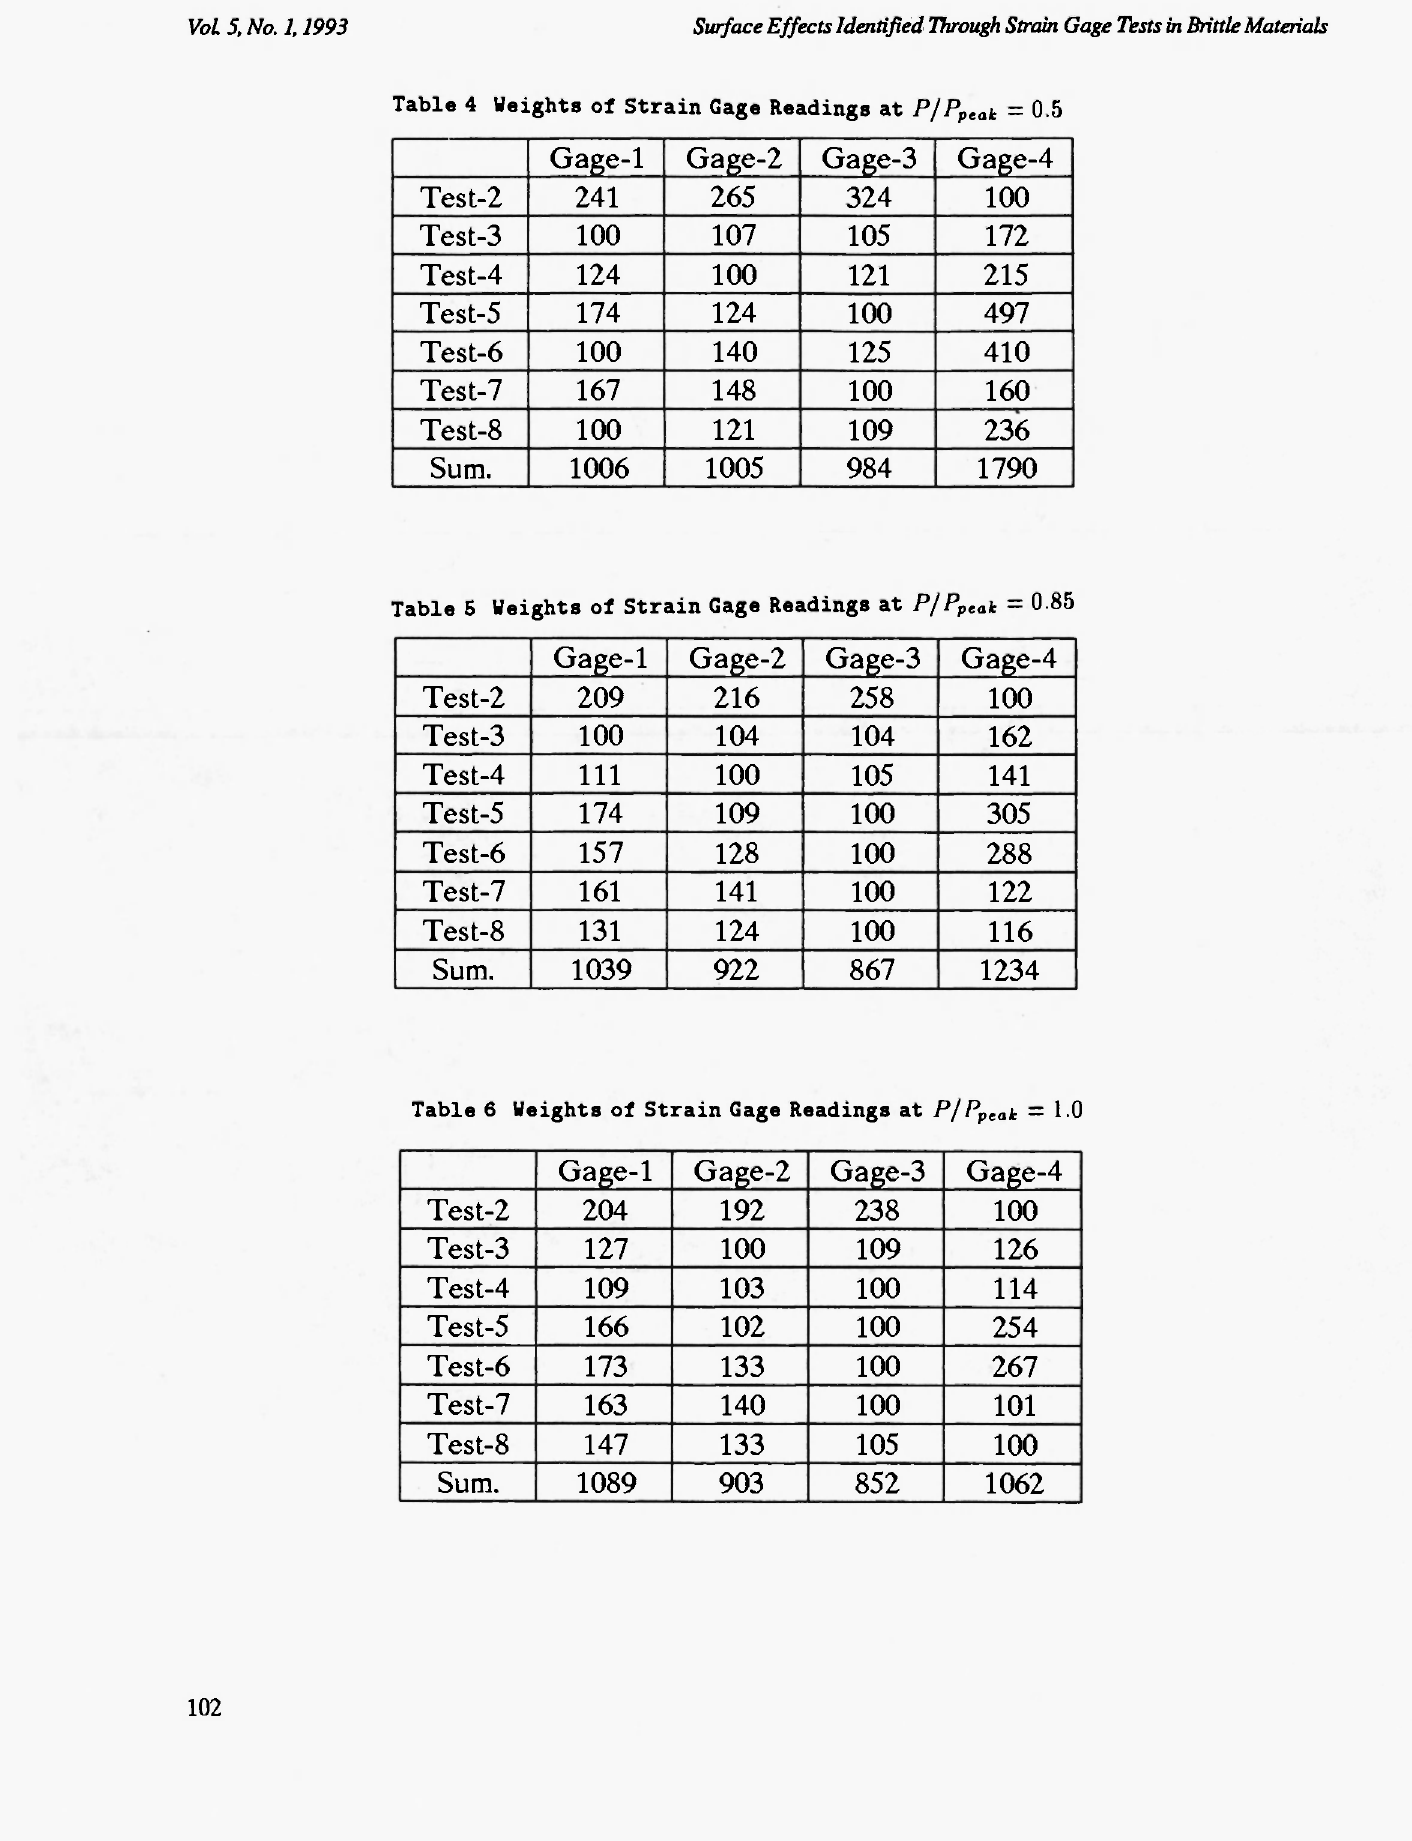
Table 5 Weights oi Strain Gage Readings at P/ P pea k = 0.85